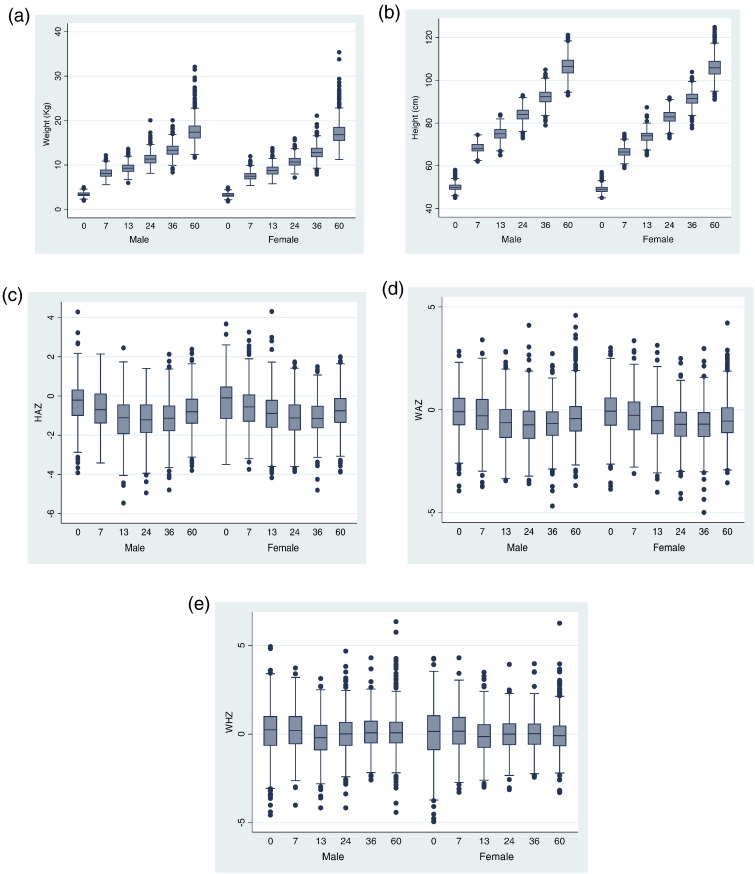
Anthropometric characteristics stratified by age and sex: (a) Weight; (b) Height; (c) HAZ; (d) WAZ; (e) WHZ. Ecuador, 2005–2009.